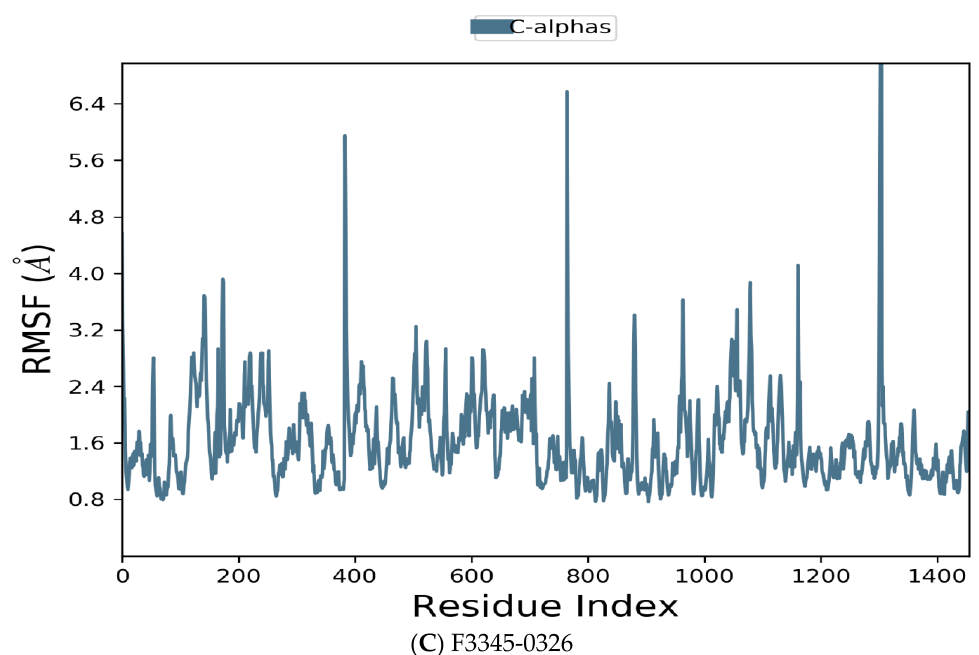
Figure 6. Residue wise Root Mean Square Fluctuation ( RMSF ) of protein with F0679-0355 ( A ), F3374-0275 ( B ), and F3345-0326 ( C ) ligands.